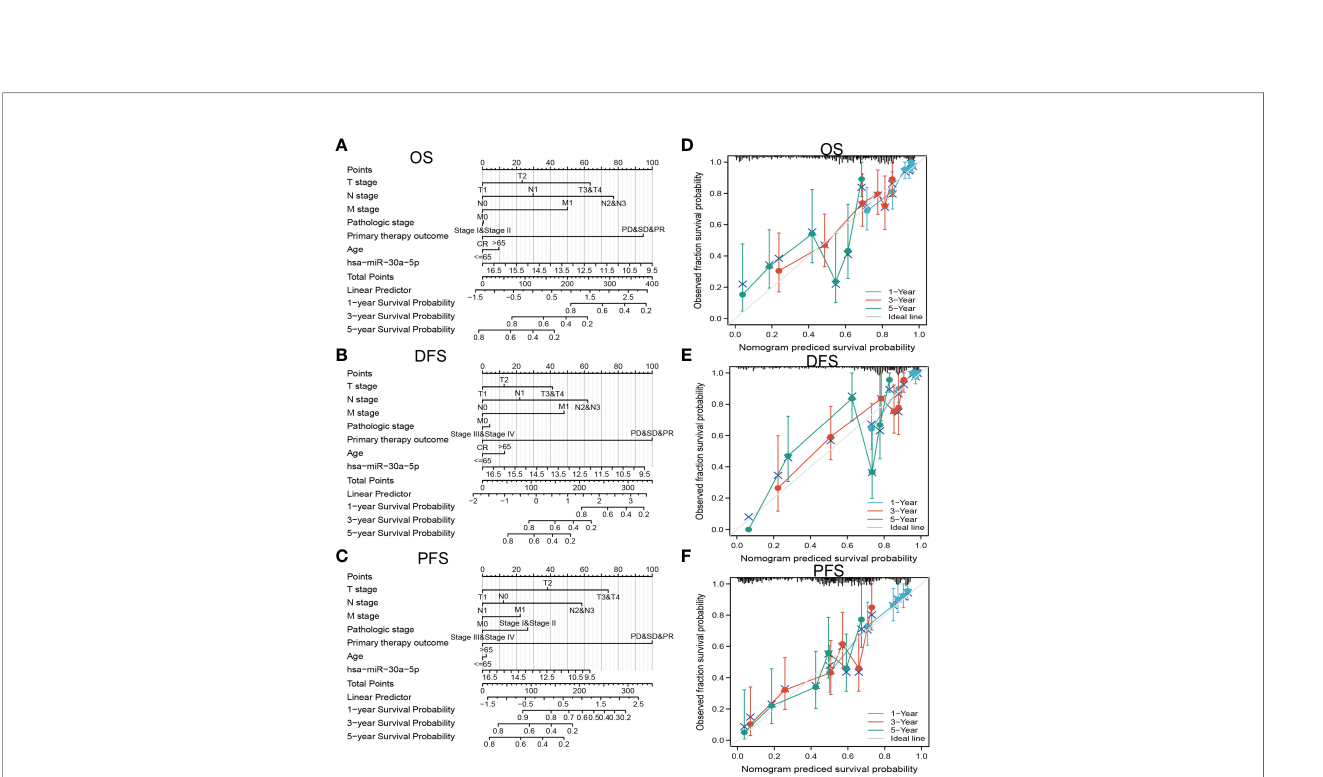
FIGURE 7 | Construction and performance validation ofthe miRNA-30a-5pbased nomogram for LUAD patients. Nomogram to predict overallsurvival (OS) (A) , disease- free survival(DFS) (B) , and progression-free survival (PFS) (C) for lungcancer patients. Thecalibration curveand Hosmer – Lemeshow test of nomogramsin theTCGA-LUAD cohort for (D) OS, (E) DSS, and (F)